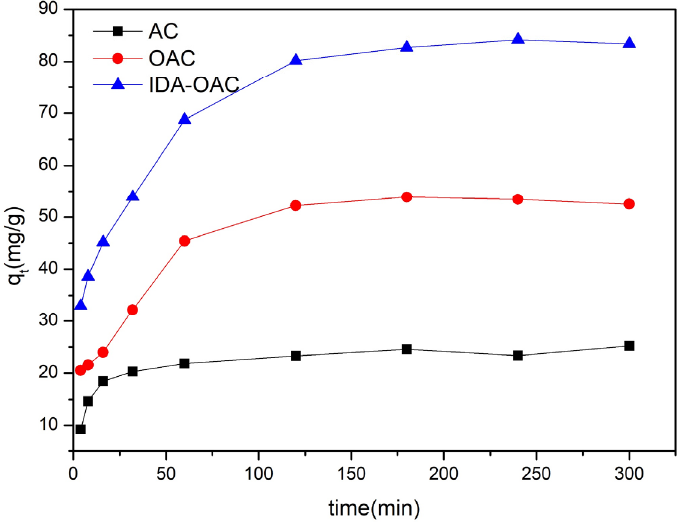
Figure 7. Effect of contact time for the adsorbents on the Cu(II) sorption.